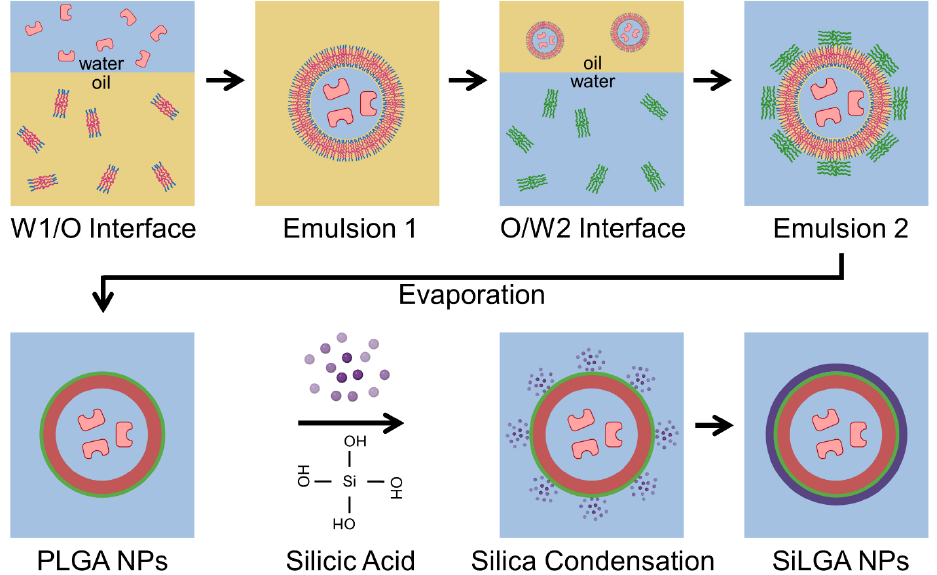
Figure 1. Synthesis of PLGA and SiLGA nanoparticles: Enzyme-encapsulated SiLGA NPs were synthesized using a water-oil-water double emulsion (PLGA NPs) and subsequent sol-gel polycon- densation reaction of silicic acid to silica. Enzyme molecules (pink) were suspended in the first water phase (“W1”; blue). PLGA molecules (red and blue) were dissolved in an organic phase (“O”; yellow). The two phases were emulsified to form “Emulsion 1”, consisting of a suspension of aqueous droplets in oil. Emulsion 1 was then introduced to a second water phase (“W2”; blue) containing PVA molecules (green). A second emulsification produced “Emulsion 2”, which consisted of an aqueous suspension of oil droplets with an aqueous core. Subsequent evaporation of the oil phase solvent yielded an aqueous suspension of PLGA NPs (red) with an enzymatic core (pink) that was stabilized by PVA (green). Subsequent introduction of silicic acid (purple dots) initiated a polycondensation reaction, forming a porous silica layer (purple) at the surfaces of the PLGA NPs to form SiLGA NPs. A portion of this figure was created using Biorender.com (BioRender 2021), accessed on 18 October